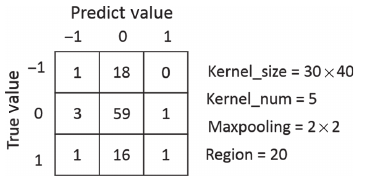
Figure 11: Confusion Matrix of Experiment 1 in Architecture 1.